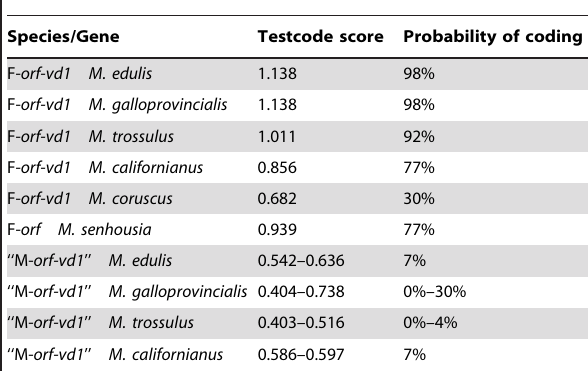
Table 3. Testcode results for Mytilus